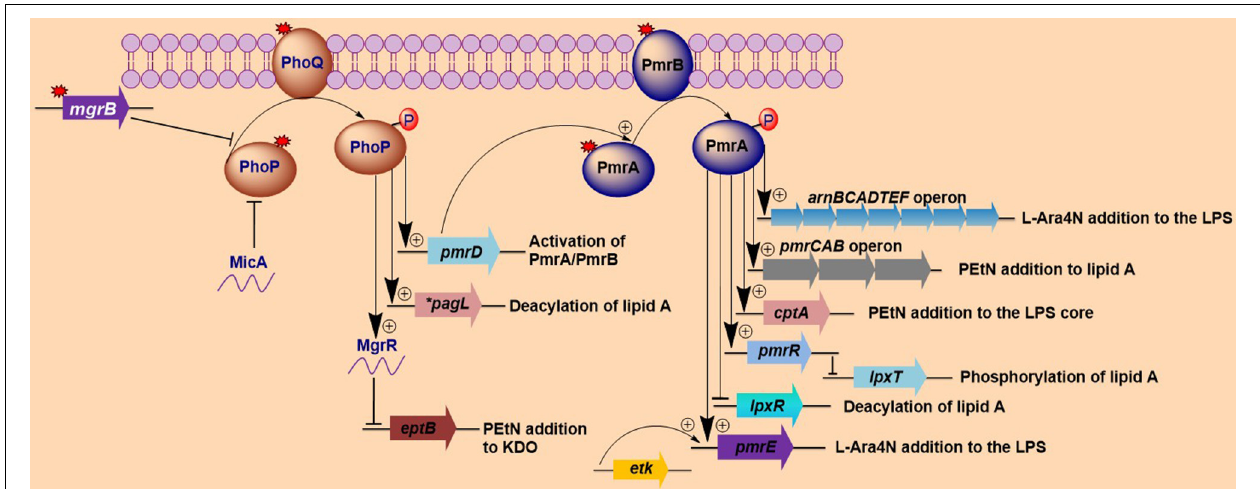
FIGURE 1 | Activation of lipopolysaccharide-modifying genes involved in polymyxin resistance in Gram-negative bacteria. Both MgrB and MicA (in Escherichia coli ) exert negative feedback on the phoP/phoQ regulatory system, while mutations (denoted by red-colored star symbols) in mgrB or phoP/phoQ typically lead to the constitutive induction of the phoP/phoQ two-component system. The activation of this two-component system ( phoP/phoQ ) activates pagL (which deacylates lipid A in Salmonella ) and pmrD (which in turn activates pmrA ) and represses eptB via the activation of MgrR, with the resultant lipopolysaccharide (LPS) modifications all participating in the mediation of polymyxin resistance. Additionally, the phoP/phoQ regulatory system can directly activates the arnBCADTEF operon in some bacteria such as Klebsiella pneumoniae . The repression of